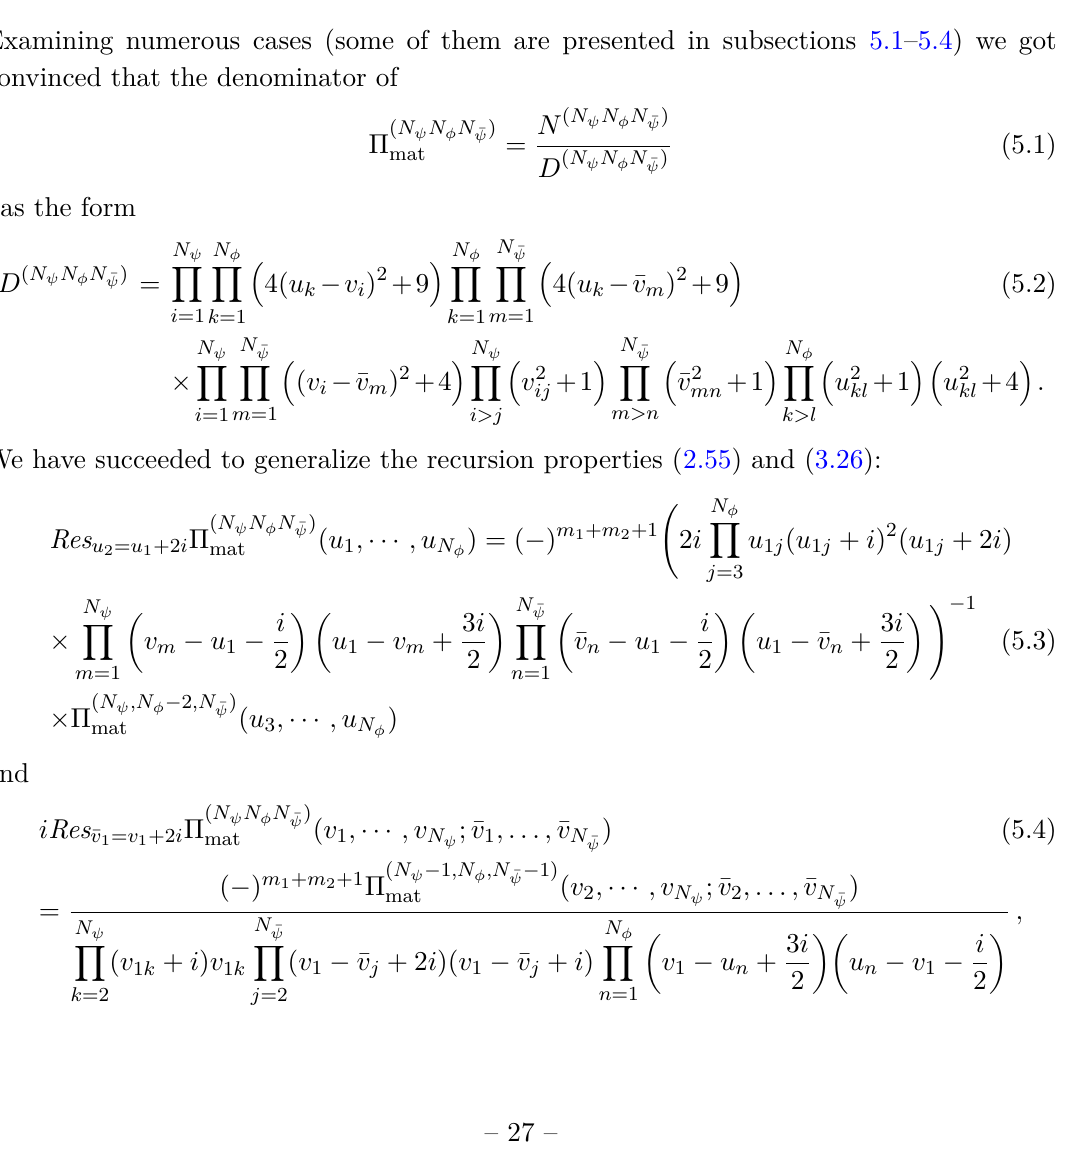
v | ¯ v j , Y ¯ v i , Y i